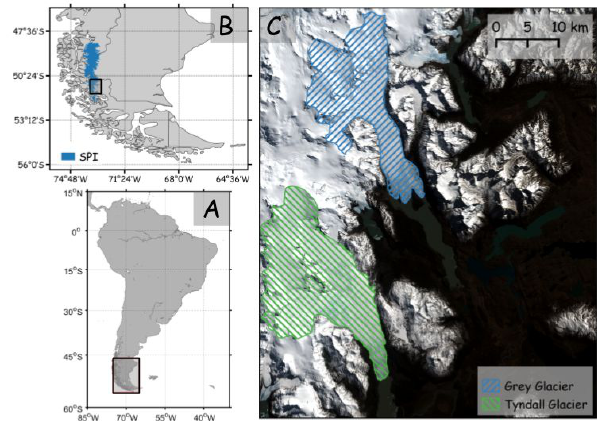
Figure 1. Location of the Southern Patagonian Icefield (SPI), the Tyndall and Grey Glaciers.